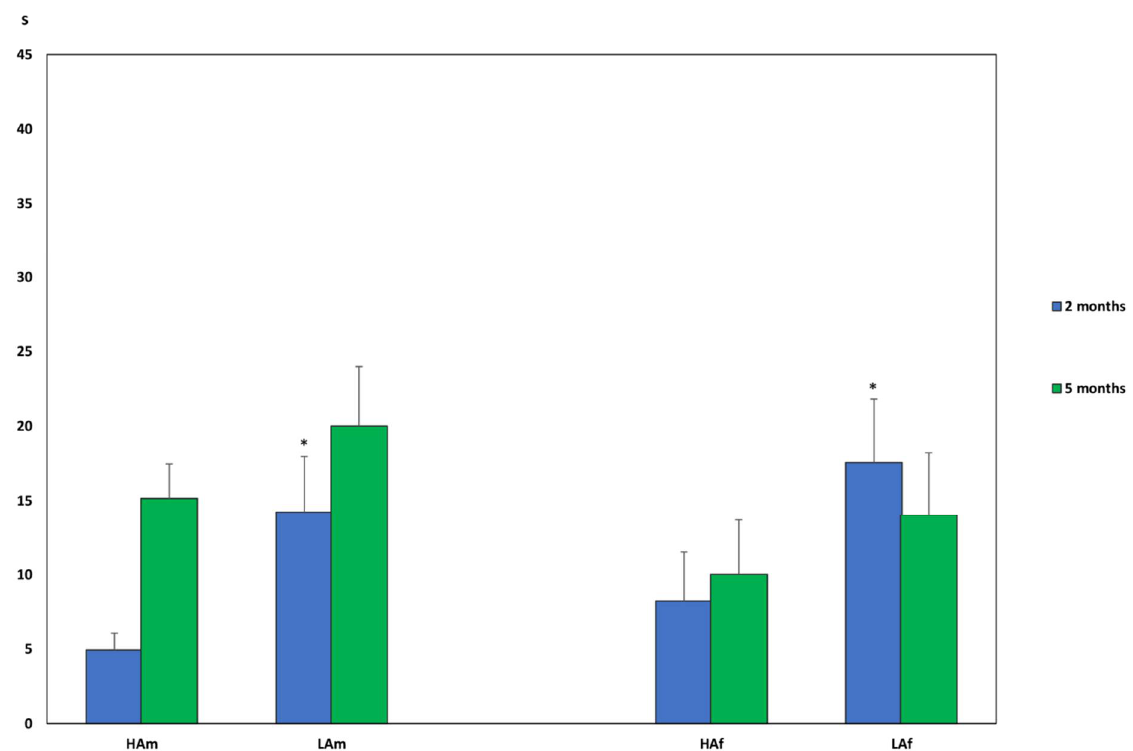
Figure 3. Time spent at the open field center. * p < 0.05 between HAm and LAm and HAf and LAf 2 month old.